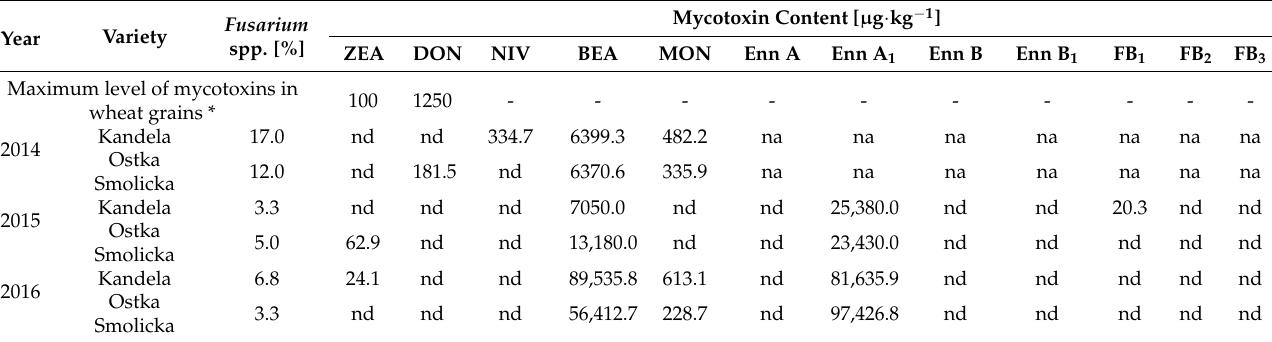
Table 6. Mycotoxin content in spring wheat